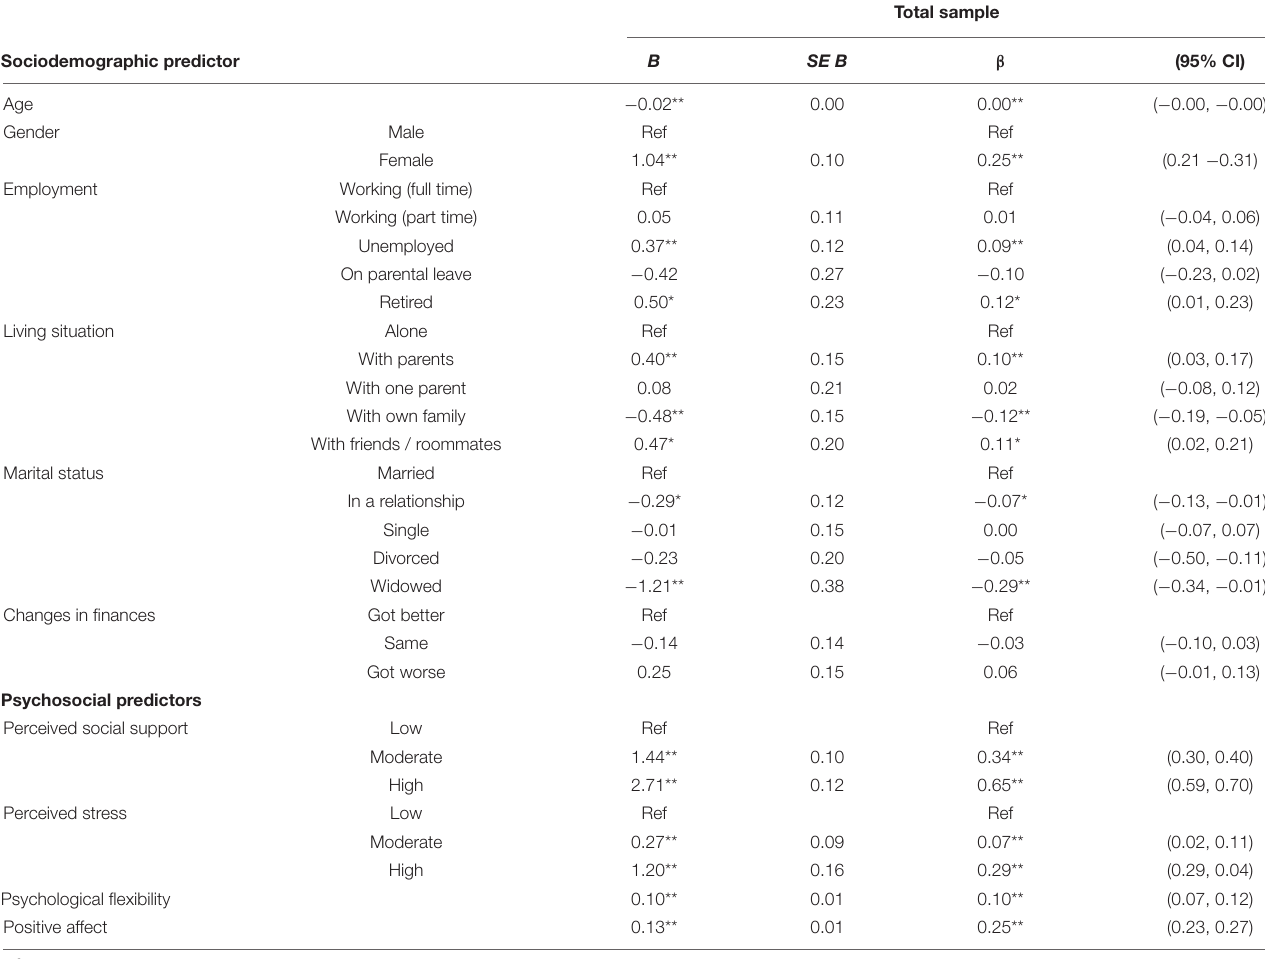
TABLE 5 | Sociodemographic and psychosocial predictors of prosocial behavior.